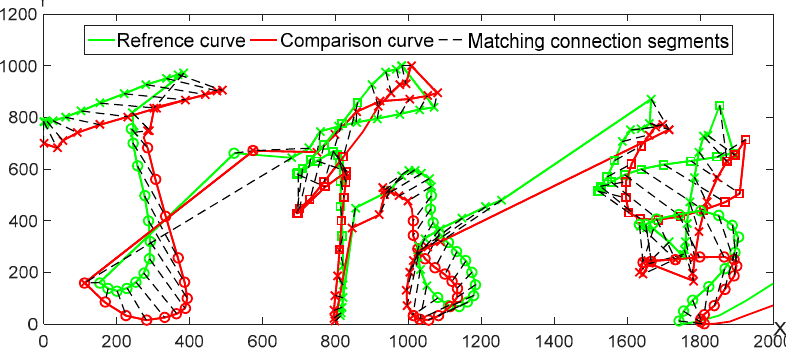
Figure 5. The matching results of two genuine signatures.